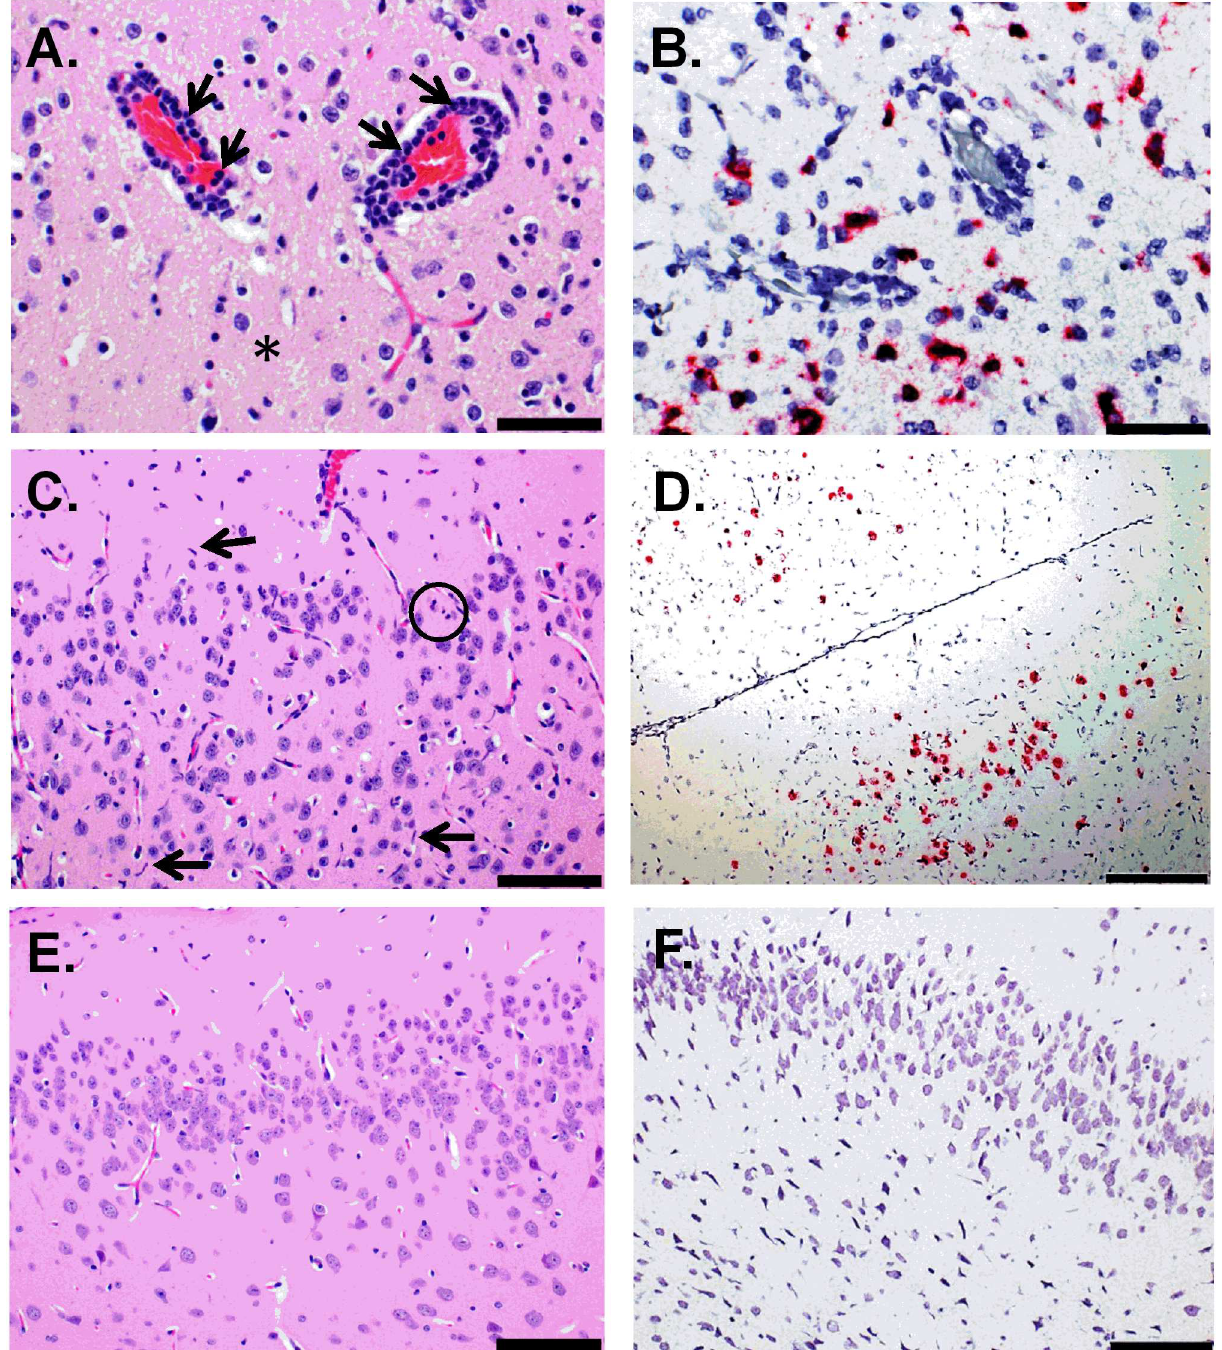
Fig 3. Histologic and ISH Findings in the Cerebrum of ZIKV-Infected Wild-type Mice Treated with an IFNAR1-Blocking MAb and Uninfected Control Mice. (A-B) The cerebrumof a mouse exposedto ZIKV intraperitoneally (IP) that succumbedon day 7 post-infection (PI). (A) Representative hematoxylinand eosin staining showedperivascular cuffing of vessels with mononuclear cells and few neutrophils (indicatedby arrows). Within the adjacent,vacuolatedneuropilthere are few neutrophilsadmixedwith scattered necrotic cellulardebris and activated microglial cells (representative area indicatedby an asterisk); scale bar represents 50 μ m. (B) Representative ISH staining demonstrating that ZIKV RNA is scattered throughoutthe same area; scale bar represents50 μ m. (C-D) The cerebrum of a mouse exposed to ZIKV IP that was euthanizedon day 11 PI. (C) Representative hematoxylinand eosin staining showedthe neuropilcontainsscattered necrotic cellulardebris (representative area indicatedby a circle) and activated microglia(representative cells indicatedby arrows); scale bar represents100 μ m. (D) Representative ISH staining demonstrating that ZIKV RNA is detected throughout the same region; scale bar